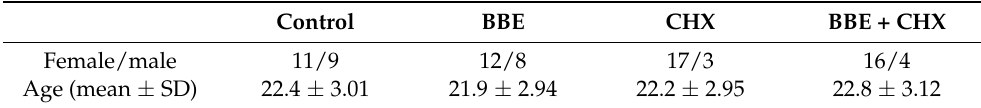
Table 1. Characteristics of patients in terms of their gender and